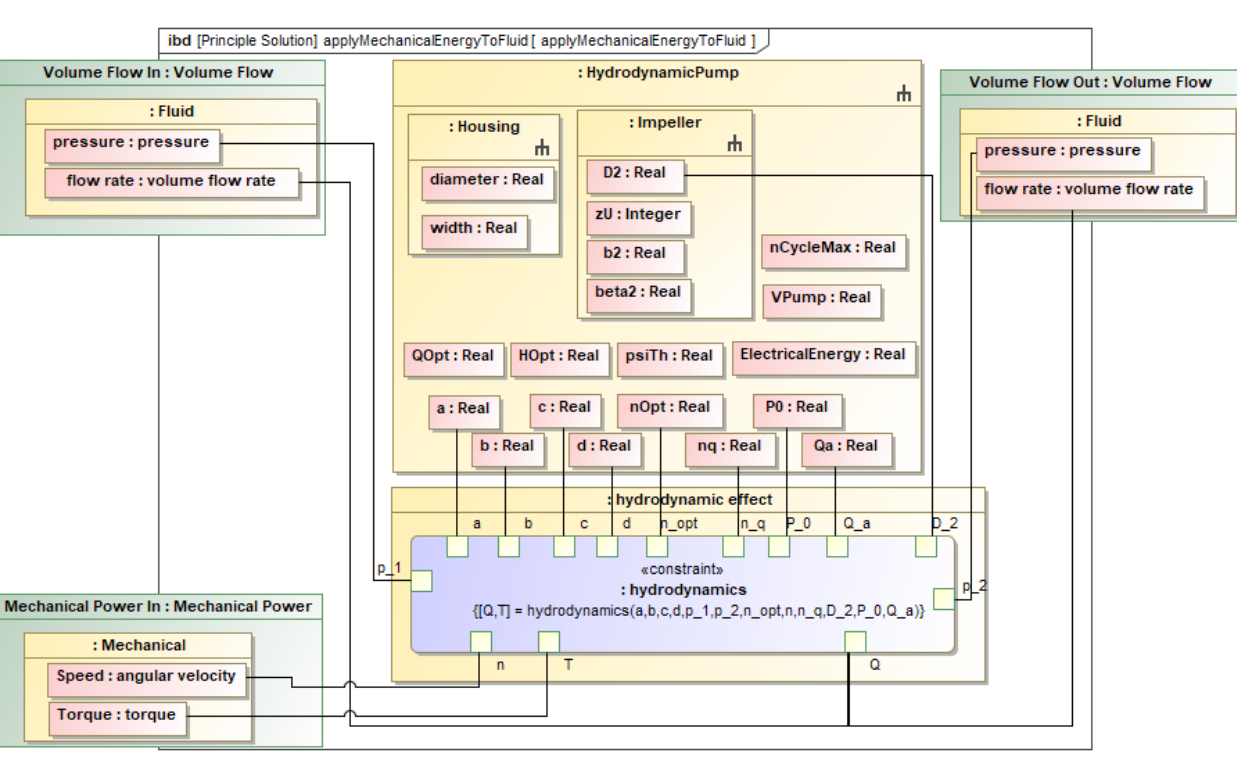
6 of 25 Figure 3. Functional architecture of the main function generate flow rate of the electric coolant pump. Principle solutions consist of a physical effect that acts in a set of active surfaces